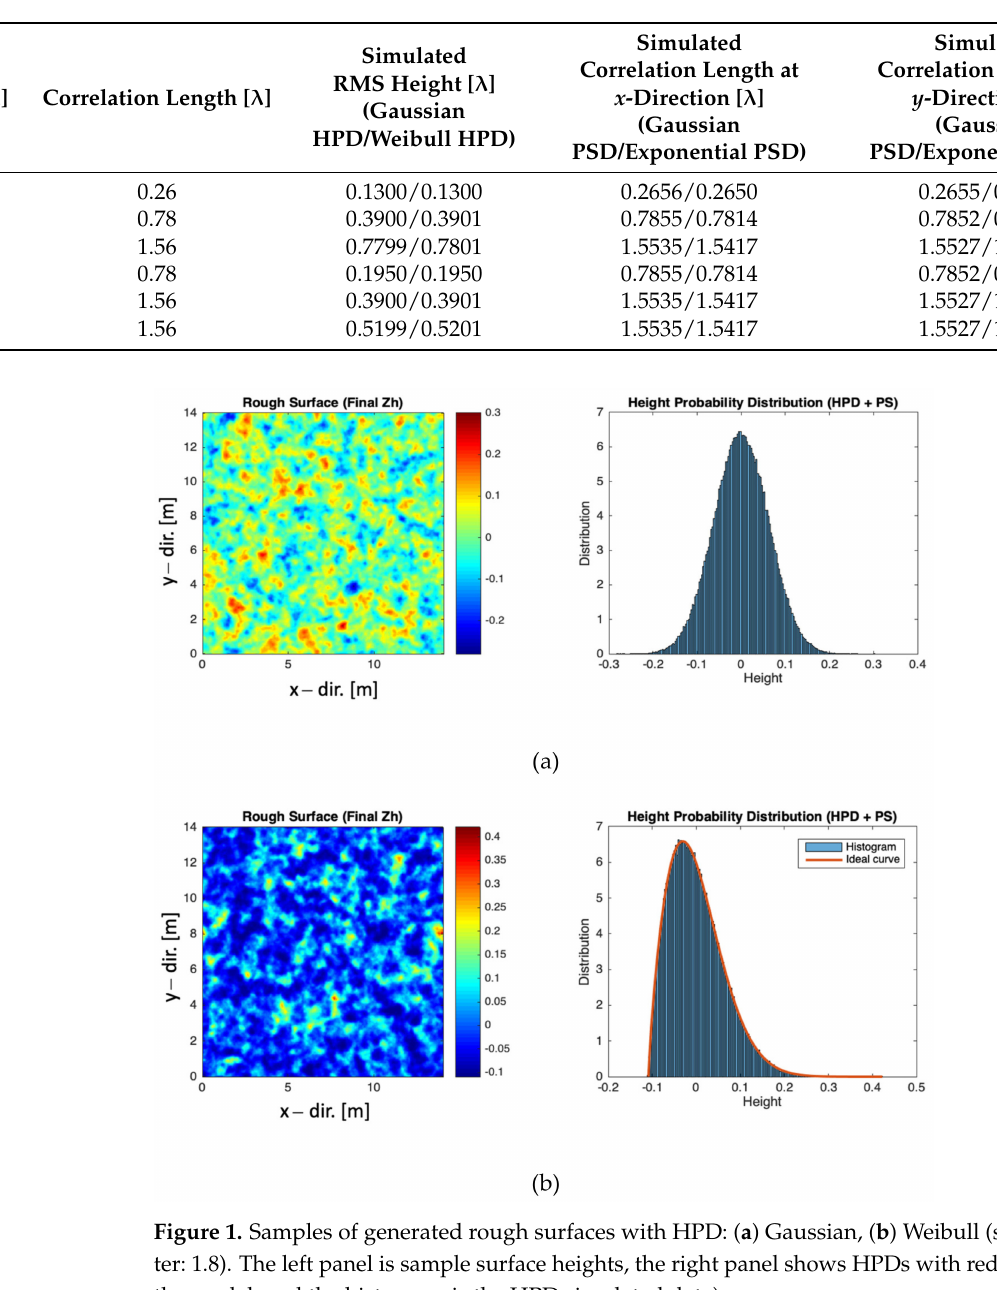
Table 1. Statistics of generated roughness surface.